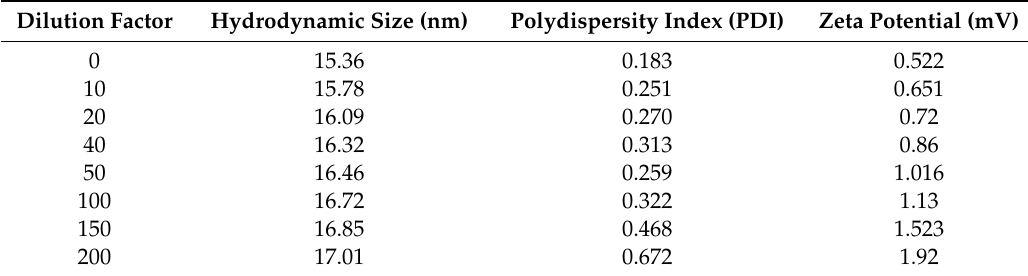
Table 3. Tacrolimus nanomicellar formulation (TAC-NMF) dilution